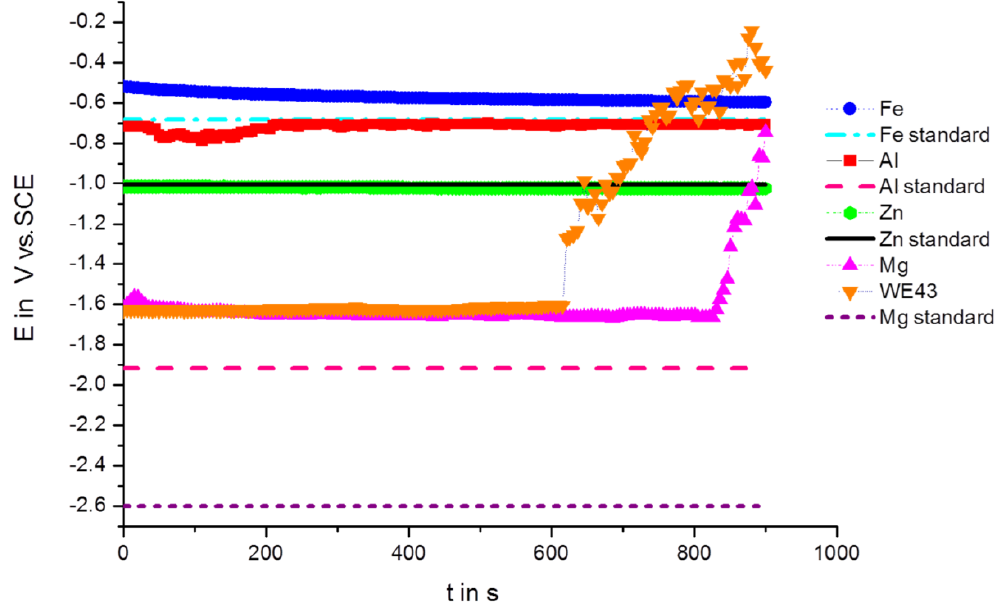
Figure 1. Open circuit potentials (OCPs) vs. time in Ringer solution for Mg, WE43, Fe, Al and